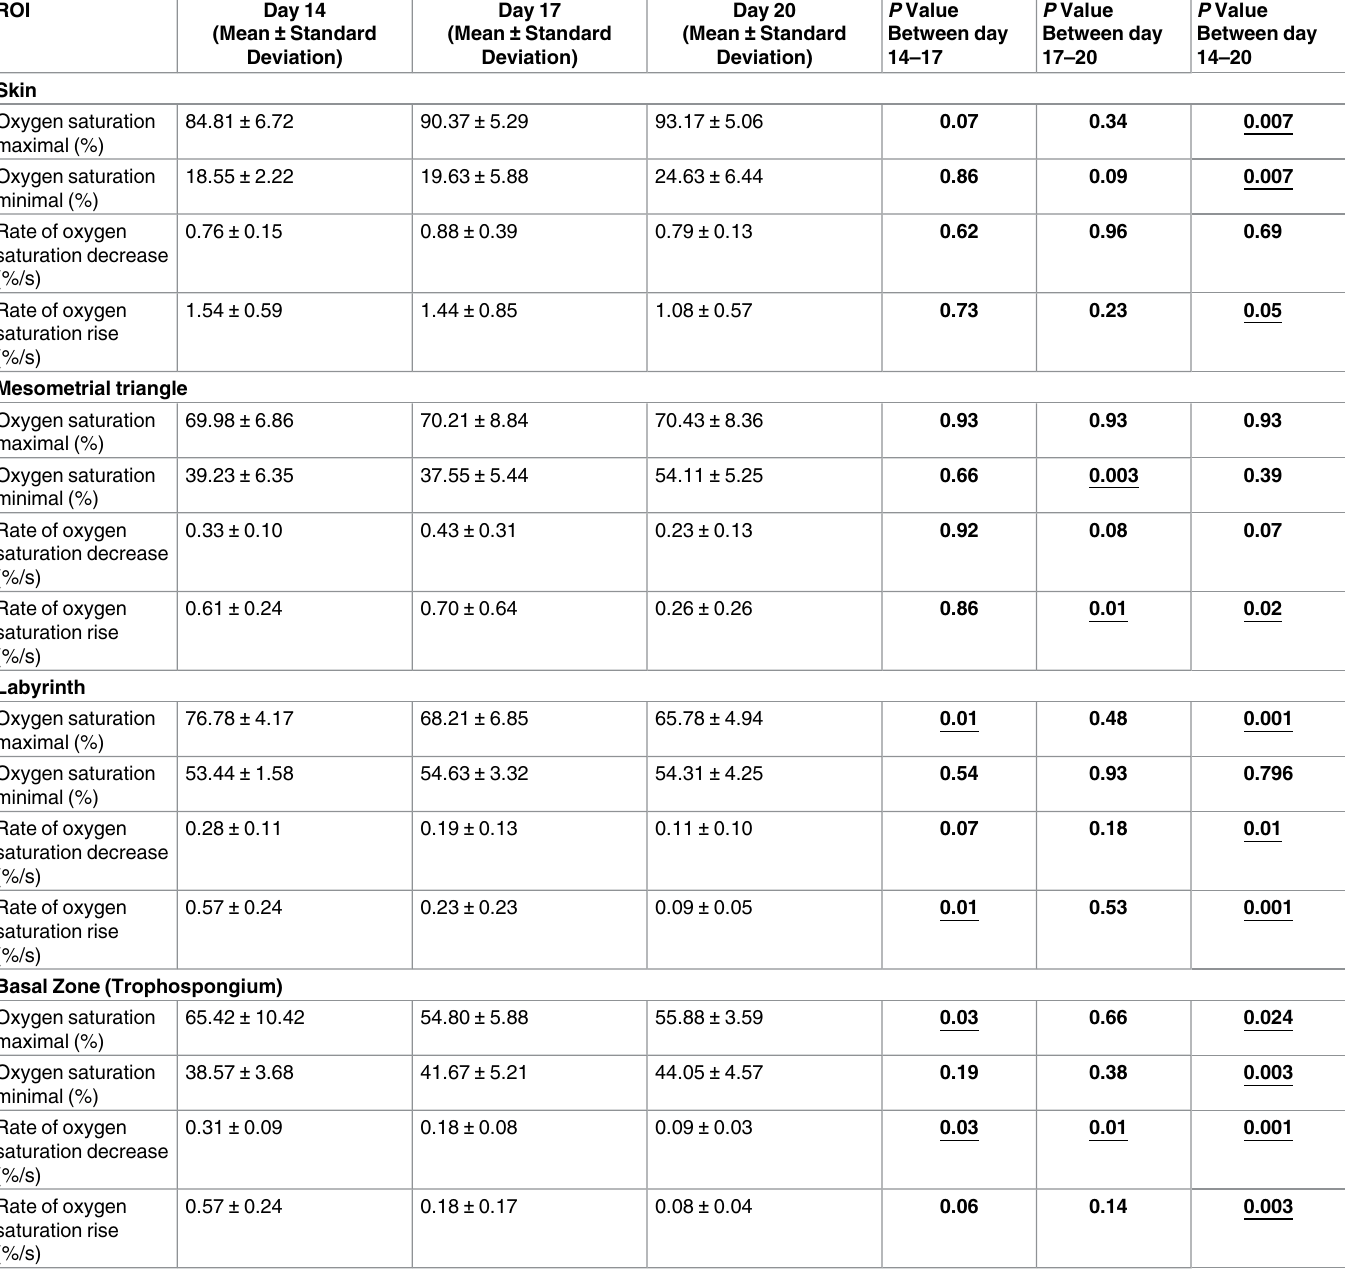
Table 1. Quantitative analysis of oxygenation in the skin and the 3 regions of interest (ROIs) of the placenta, on days 14, 17 and 20 of gestation (pooled data). Results are presented as mean ± standarddeviation.